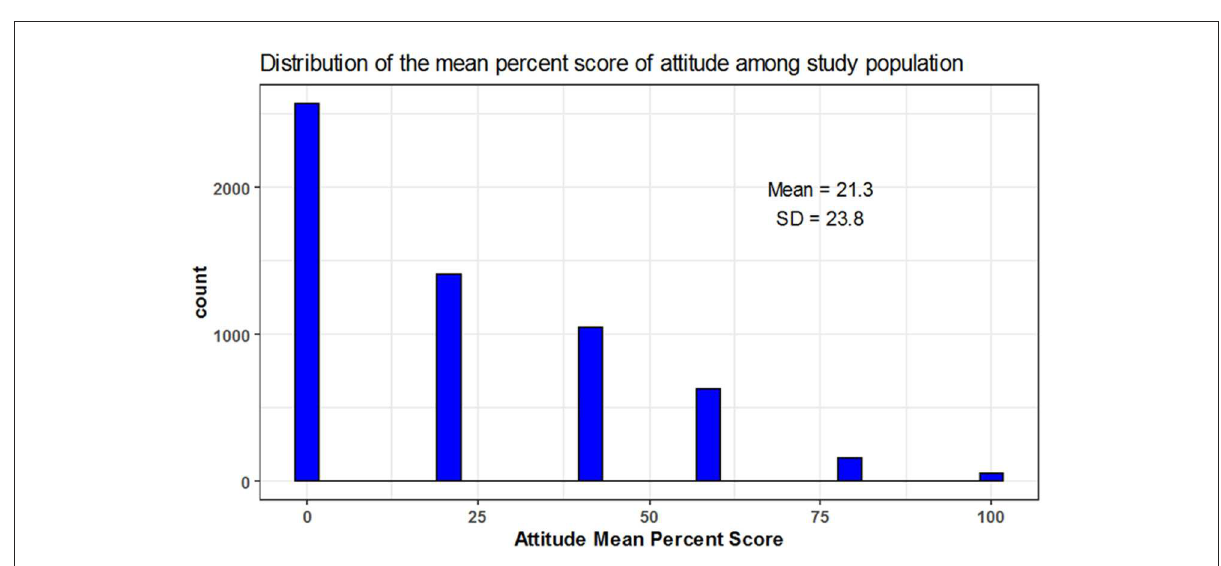
FIGURE4 Mean percent score distribution for attitude figure.